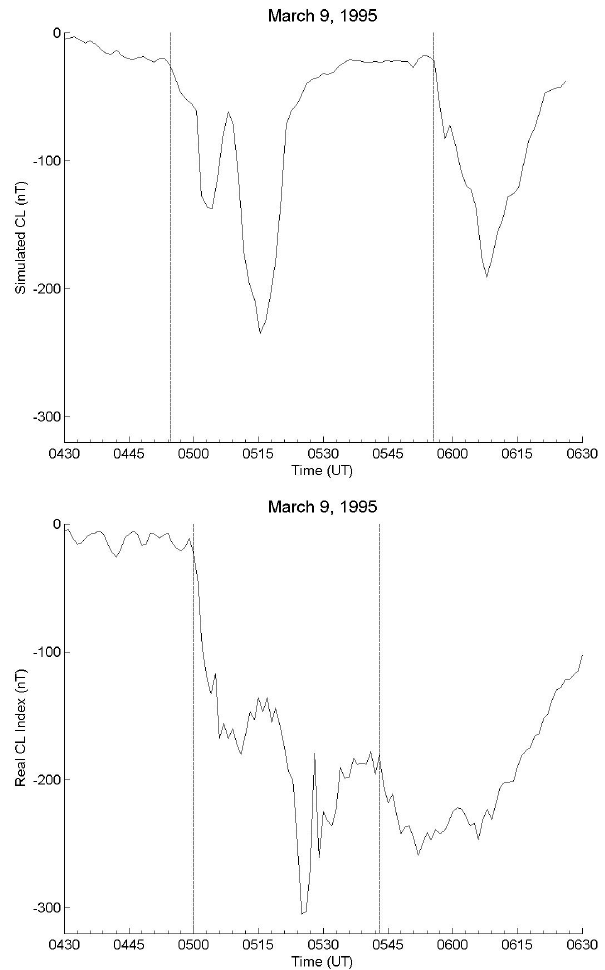
Fig. 2. Substorm expansion phase onset (first vertical line) and a second onset (second vertical line) on 9 March 1995. The real CL index is in the bottom panel and the simulation index is in the top